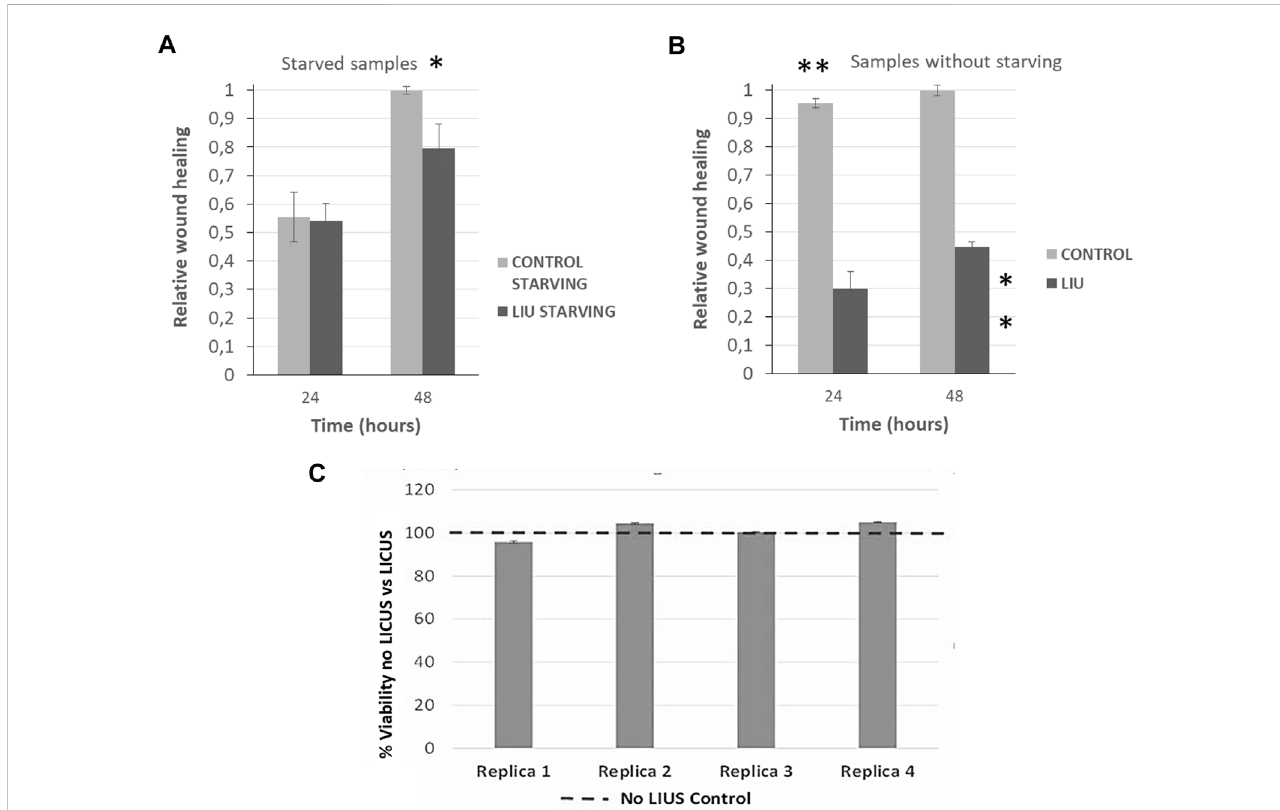
FIGURE 5 Quanti fi cation of relative wound closure of PANC-1 cells in normal conditions (grey bars) and after 20 min of LICU actuation (black bars) after 24 h and 48 h(n=3)in (A) starvedmonolayersand; (B) innon-starvingconditions. Statisticalsigni fi cance* p ≤ 0.05,** p ≤ 0,01. U Mann-Whitneytest; (C) Analysisofcell viability after LICUs treatment using Alamar BLUE assays performed in four replica